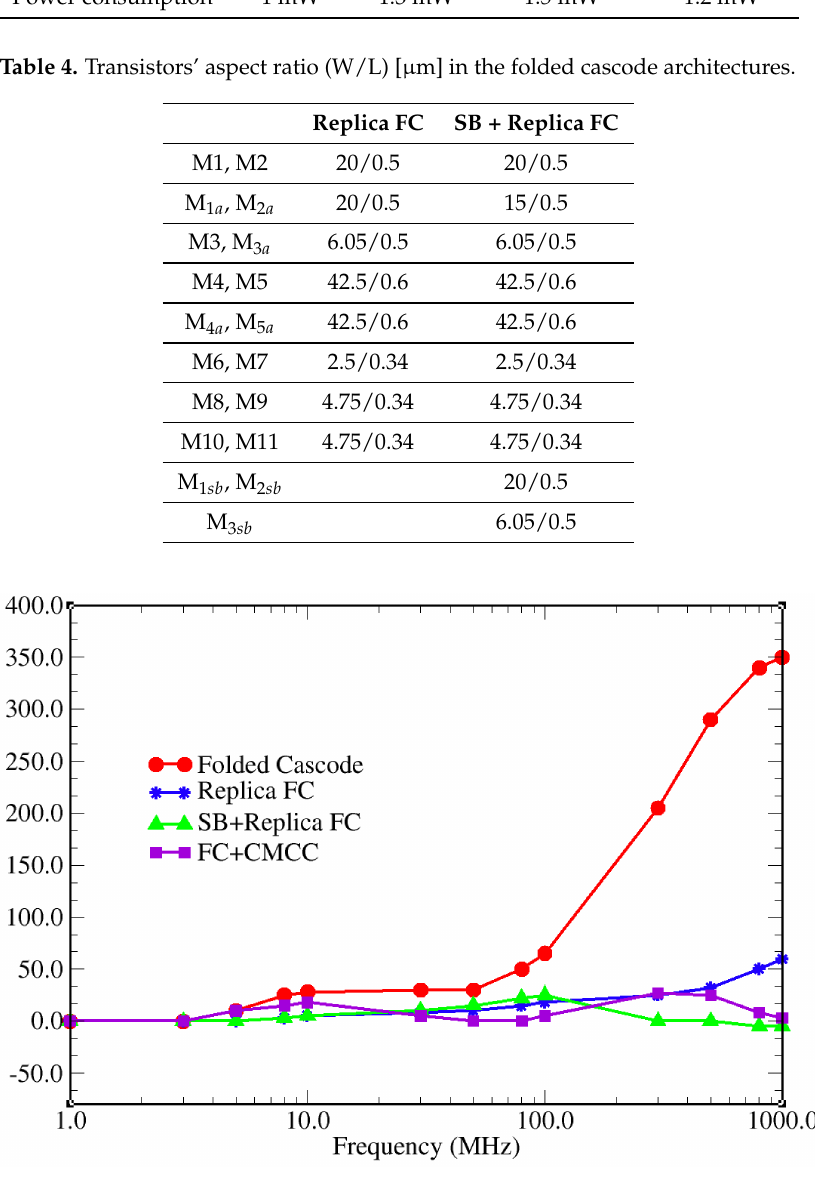
Figure 11. Offset induced by 1.65 Vpp EMI injected into the input pin of FC